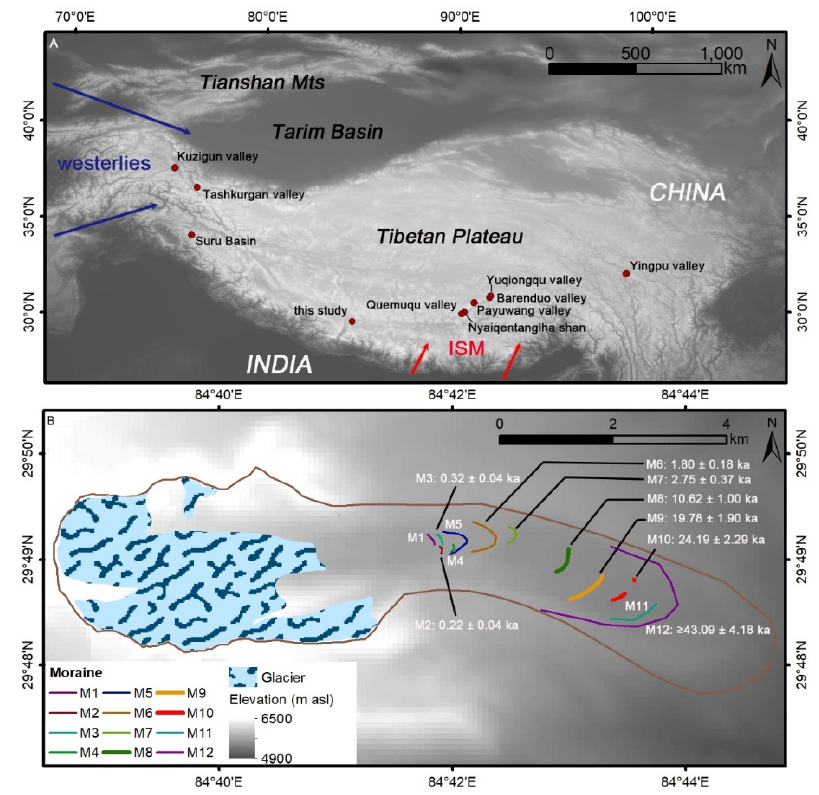
Figure 1. ( A ) Locations of the study area and previous study sites [18–25]. ( B ) Modelled domain with the locations and exposure ages of moraines. Ages were based on Zhang et al. [2].